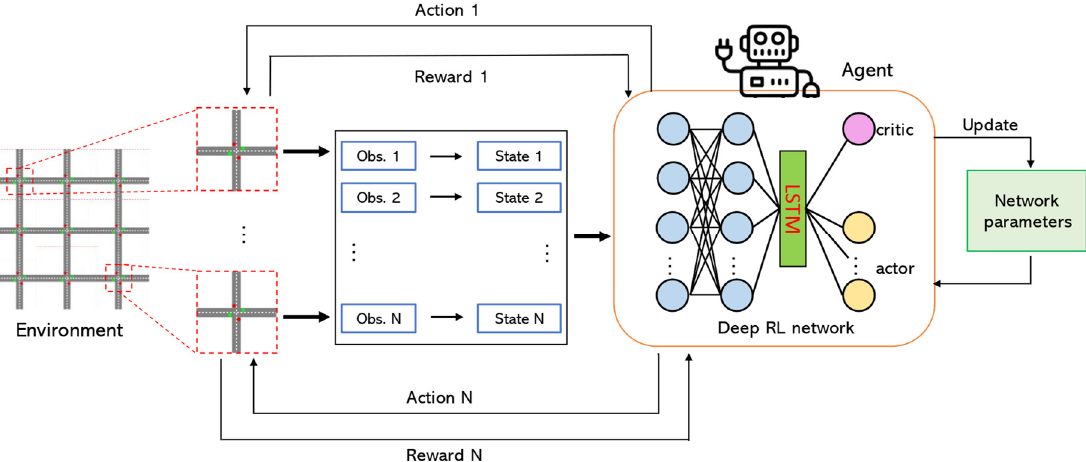
Figure 4. The overall framework of the proposed method. Each deep RL agent controls its own intersection in the environment.